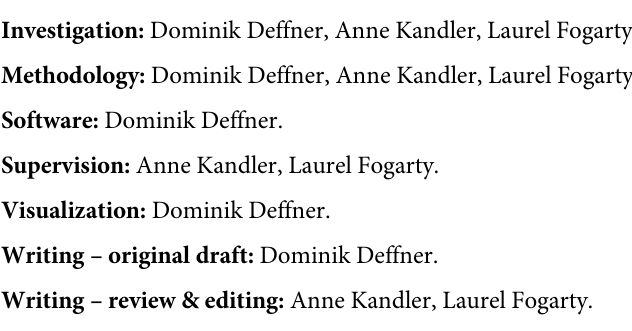
focal population. We start by letting a large source population with N = 10000 and a small focal population with N = 100 evolve separately until they reach equilibrium; each generation, we then let a fixed number of individuals migrate from the source population to the focal pop- ulation and record effective numbers and diversity indices in the focal population. Effective population size (left), number of unique cultural variants (on log scale; center) and Simpson Diversity (right) for different innovation rates μ . Plots show trajectories for 150 generations after immigration starts (1000 independent simulations with 50 immigrants per